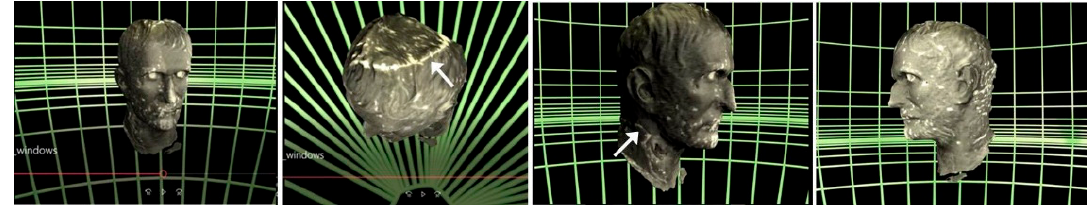
Figure 13. 3D representation of the thermographic results obtained for the Capitoline Brutus. The arrows indicate the junction line on the neck and the skullcap.